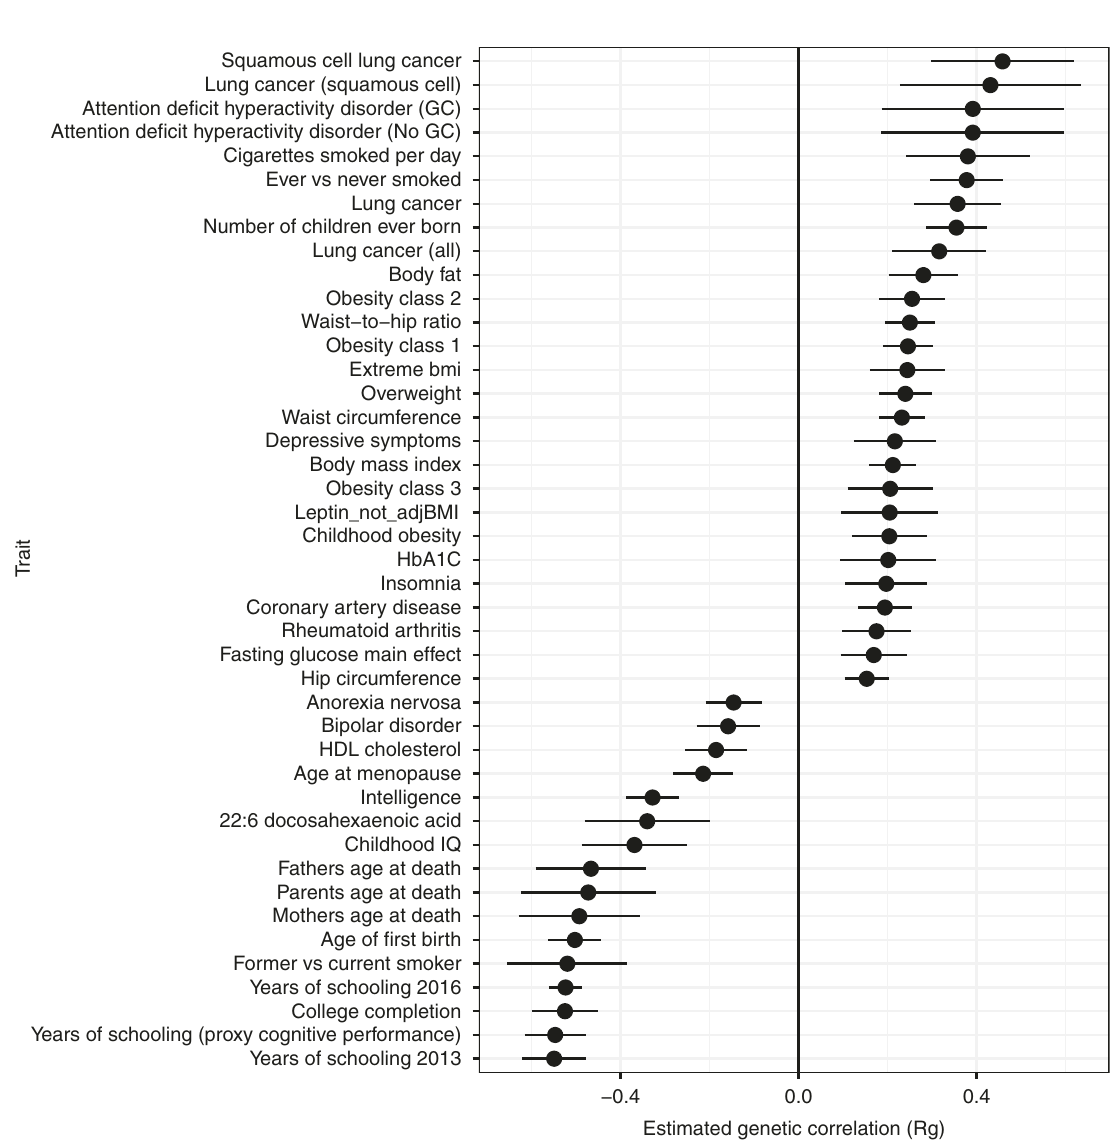
Fig. 3 Estimated genetic correlations between DMFS/dentures and health traits or outcomes. Markers indicate the estimated magnitude of R g , error bars represent 95% con fi dence intervals (1.96* LDSR standard errors on either side of the point